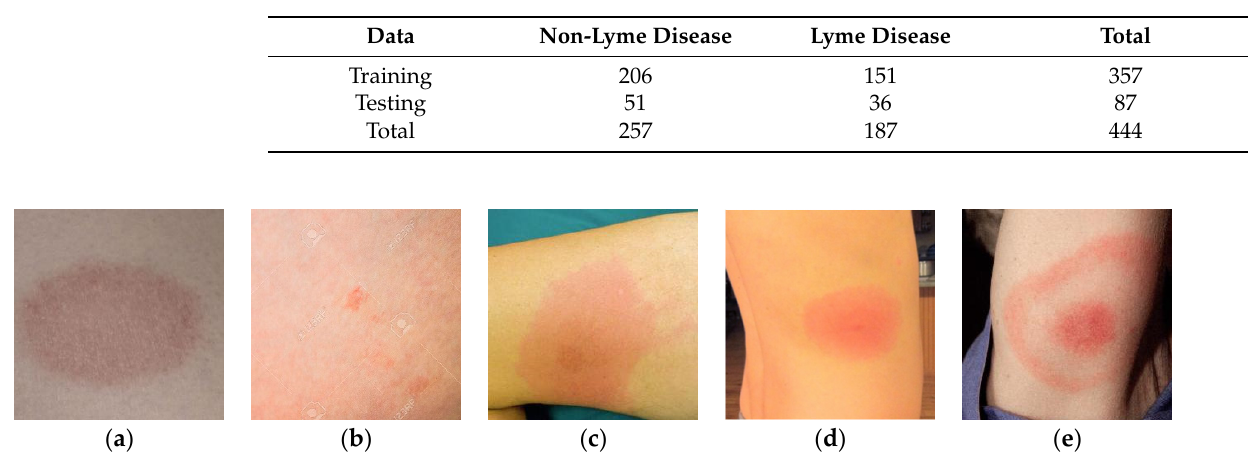
Figure 11. ROC curves for the compared networks with different losses on the Chest-2 dataset. Table 7. The construction of the rash image dataset.